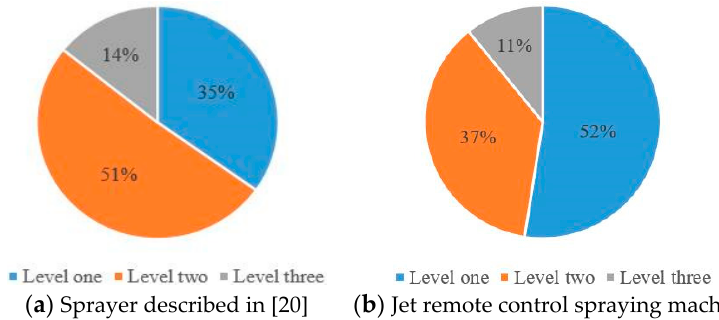
Figure 13. The percentage of droplet deposition density in each layer of the fruit tree canopy.